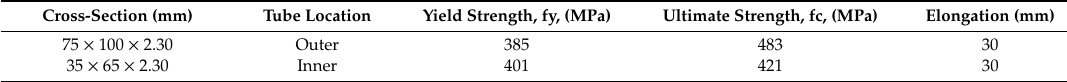
Table 1. Hollow steel tube